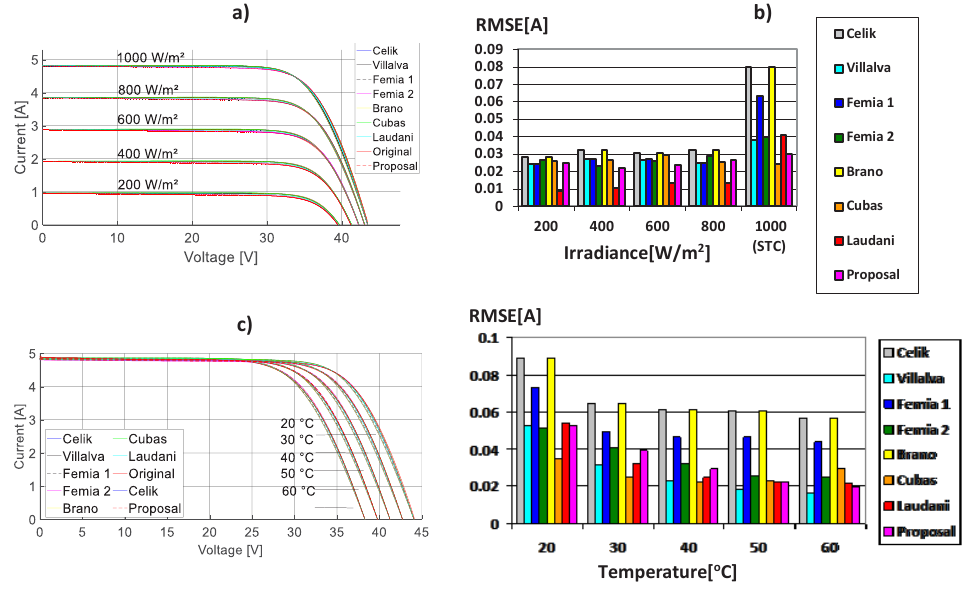
Figure 4. Comparison between the calculated (eight models) and maker I-V curves of Shell SQ150-PC: ( a ) at T = 25 ◦ C; ( b ) RMSE at T = 25 ◦ C; ( c ) at G = 1000 [W/m 2 ]; ( d ) RMSE at G = 1000 [W/m 2